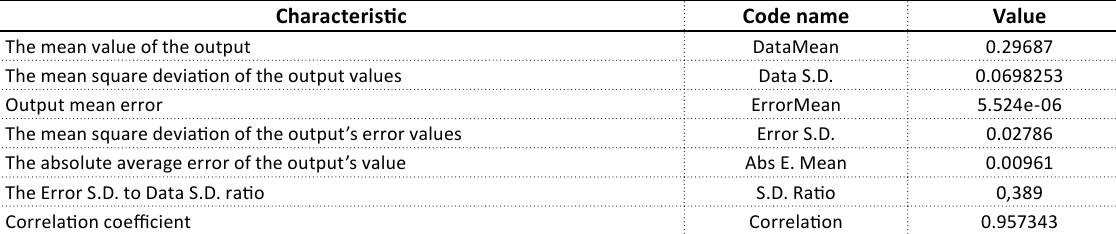
Table 5. Quality characteristics of the multilevel perceptron model Characteristic